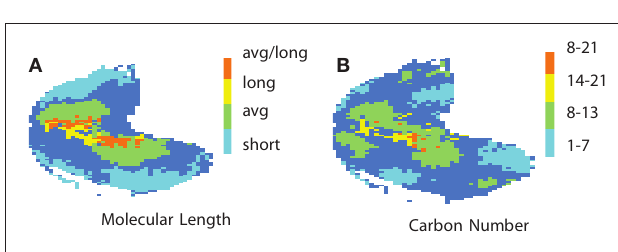
Figure 3 | Localization of molecular properties. In (A) you see the molecular length across the OB. See the legend for the color code. (B) Shows carbon numbers. The legend explains the